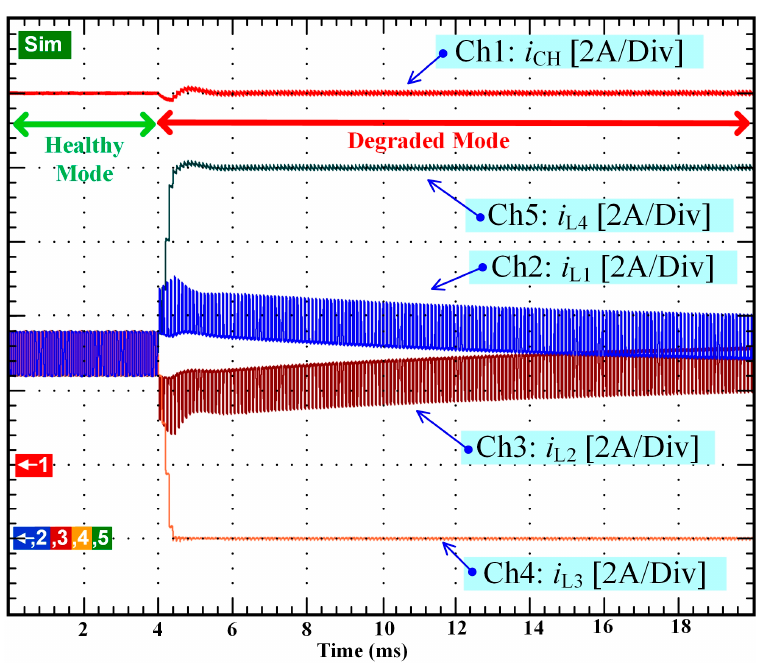
Figure 10. Simulation results: transient after fault detection with re-phase and compensation.